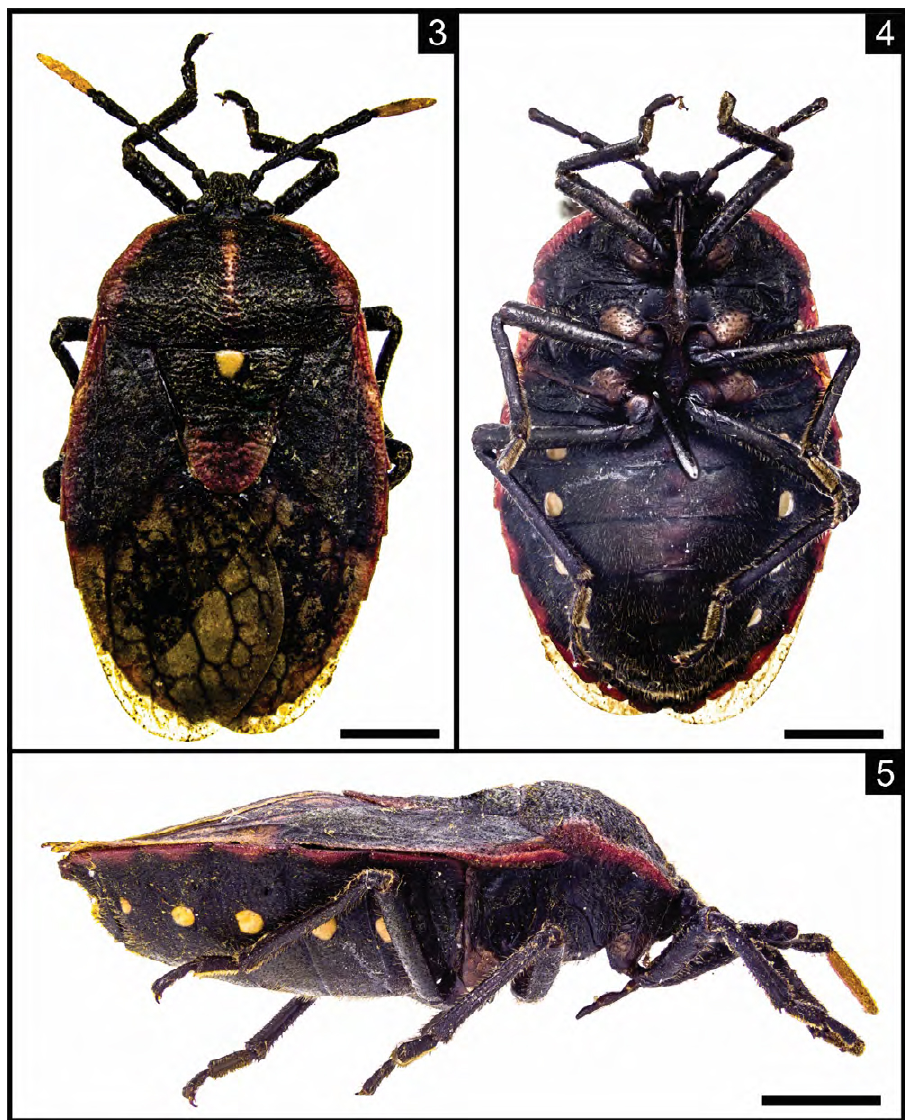
Figures 3–5. Female of Dinidor mactabilis collected in the State of São Paulo and key diagnostic features. 3: Dorsal view, external lateral margins of pro- notum colored in red and the longitudinal median red band. 4: Ventral view, lateral margins of pronotum colored in red. 5: Right lateral view, blackened intersegments of the urosternite. Scale bar is 3 mm. Photos by B.C.